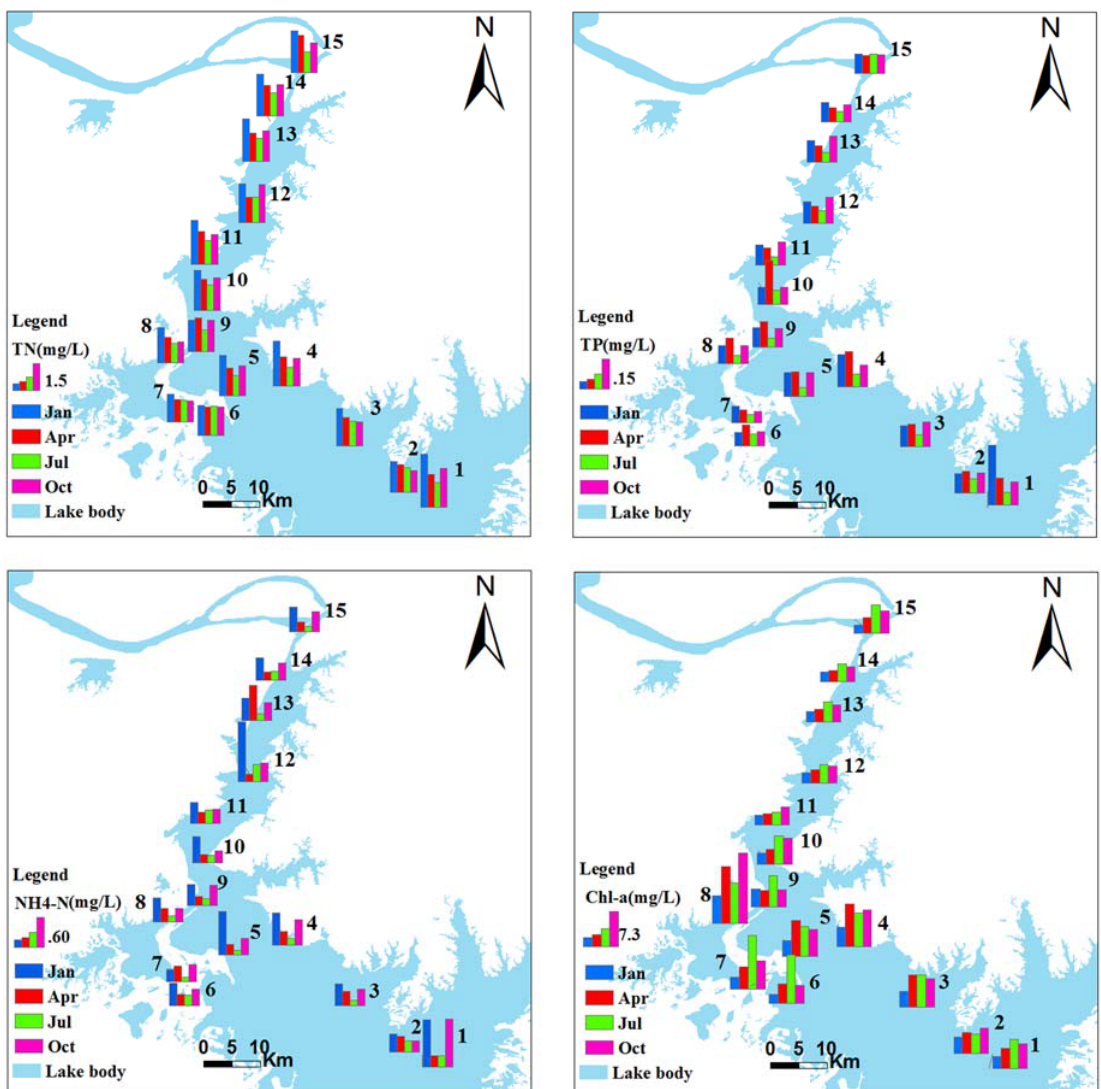
Figure 4. Spatial and seasonal variations of TN, TP, NH4–N and Chl–a in Poyang Lake.